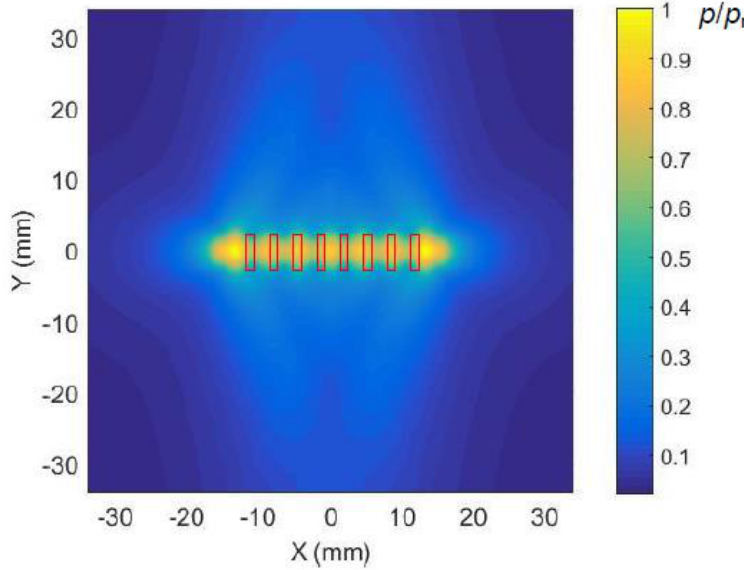
Figure 9. Calculated ultrasonic pressure field in air radiated by the eight-element rectangular array at the distance R = 1 mm from the array when all elements of the array are excited simultaneously. The presented amplitude values shown in the color bar were normalized with respect to the maximum value in the